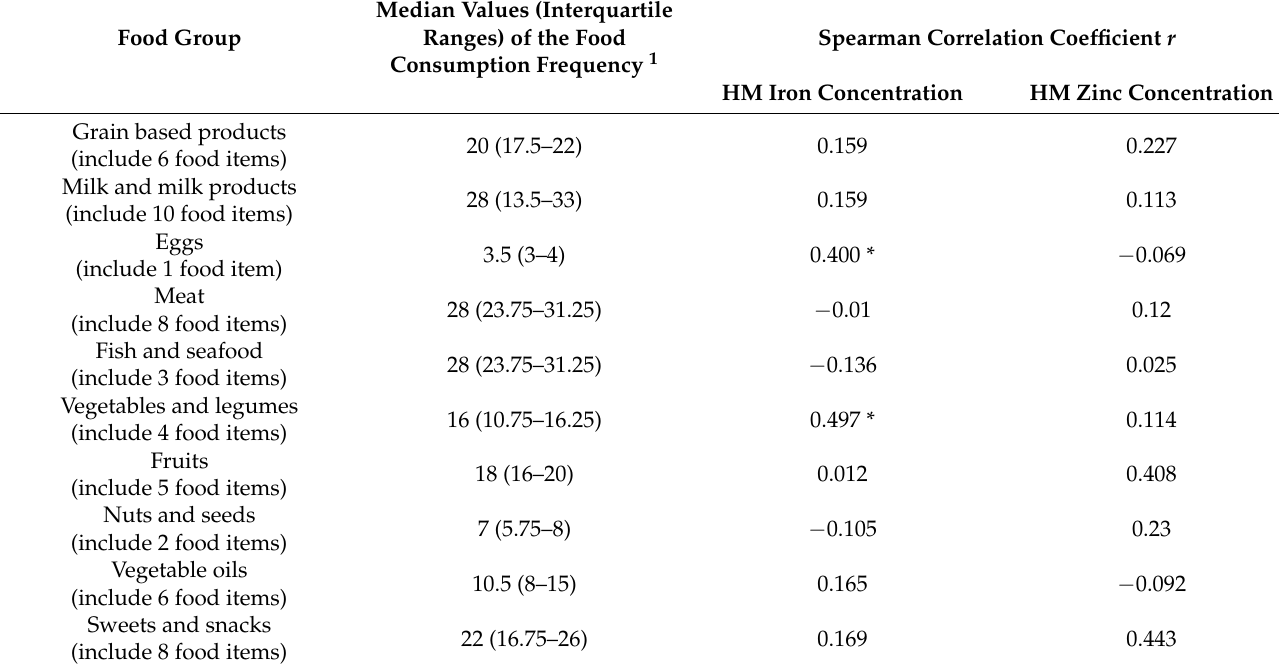
Table 6. Food intake frequencies and correlation with iron and zinc concentrations in